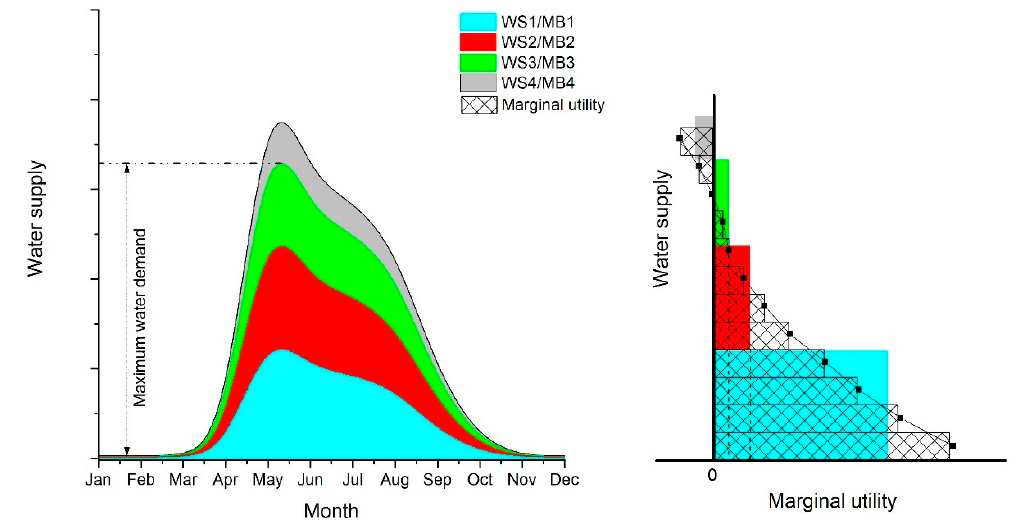
Figure 2. A schematic of the piecewise water supply and the corresponding marginal utility functions.